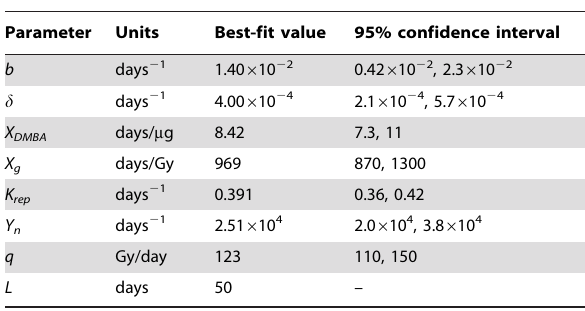
– Parameter interpretations are: b =pre-malignant niche replication rate; d =the parameter for homeostatic regulation of the number of pre-malignant cells per niche; X DMBA and X g =cell initiation constants for DMBA and c -rays; K rep =constant for repair of c -ray-induced cell-initiating damage; Y n =neutron- induced bystander promotion constant; q =radiation dose rate at which 50% of all susceptible cells are activated by radiation-bystander signals under steady- state conditions; L =lag time between the appearance of the first malignant cell and tumor